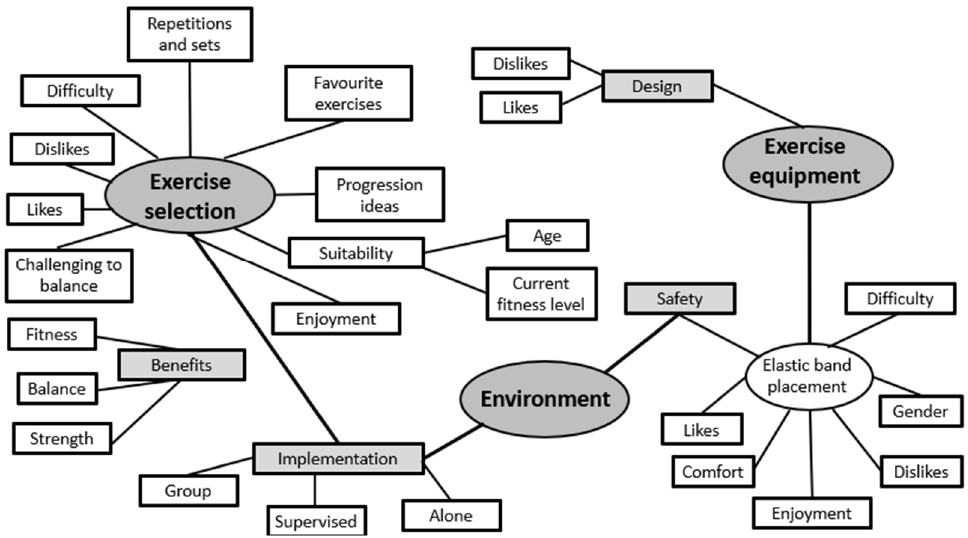
Figure 3. Figure to illustrate the key themes and the interconnectivity of the themes and sub-themes.